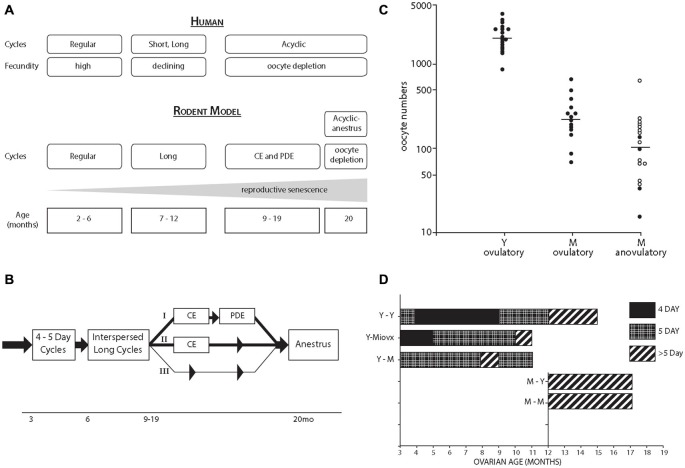
(A) Comparison of perimenopausal transitions in women and rodents (lab mouse and rat). The most common initial acyclic state of rodents, CE is driven by continued ovarian estradiol (E2) production at low levels with hypothalamic impairments of the E2-dependent preovulatory gonadotrophin surge. Alternate pathways with persistent diestrus (PDE) are shown in panel B. The terminal state of anestrus with total oocyte depletion arise after 20 month, with LH elevations as in postmenopausal women. Rodent perimenopause occupies a larger fraction of the 28 month life span than for women, spanning the onset of cycle irregularity after 6 month to ovarian follicle depletion after 20 month, which comprises half the lifespan. For details, see Nelson et al., 1982; Felicio et al., 1984; Finch et al., 1984; Gee et al., 1983; Finch, 2014. (B) Rodent perimenopausal transitions with alternate trajectories from lengthening cycles interspersed with 4–5 day ovulatory cycles (I) CE followed by PDF (repetitive pseudopregnancy), and thence to anestrus; (II) CE directly to anestrus; (III) Lengthening cycles leading directly to anestrus (least common). Adapted from Finch et al. (1984), (C) Studies on C57BL/6J mice from the Finch lab. Ovarian oocyte numbers in Y (young, 4–5 month) and M (middle-aged, 13–14 month); the M were grouped by the occurrence of recent ovulation. Horizontal lines are median values. From Gosden et al. (1983). (D) Heterochronic ovary transplantation between Y and M ages. The MLovx were ovariectomized (OVX) at 3 month and given ovaries at 12 month; their aging without exposure to ovarian steroids maintained the potential for 4 day cycling, not seen in Y-M transplant. Redrawn from Felicio et al. (1986).